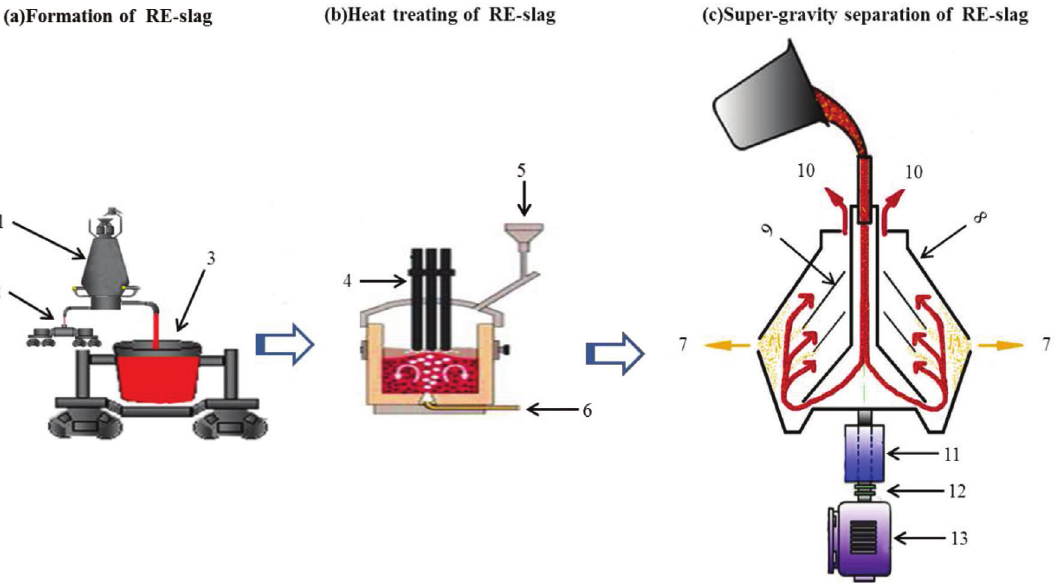
Fig. 1: Technical route to effectively utilize the rare-earth-rich slag (1. Blast furnace; 2. Hot metal ladle; 3. Slag ladle; 4. Heating system; 5. Feeding system; 6. Bottom blowing system; 7. Britholite particles; 8. Rotating drum; 9. Conical disc; 10. Tailings; 11. Bearing; 12. Coupling; 13.